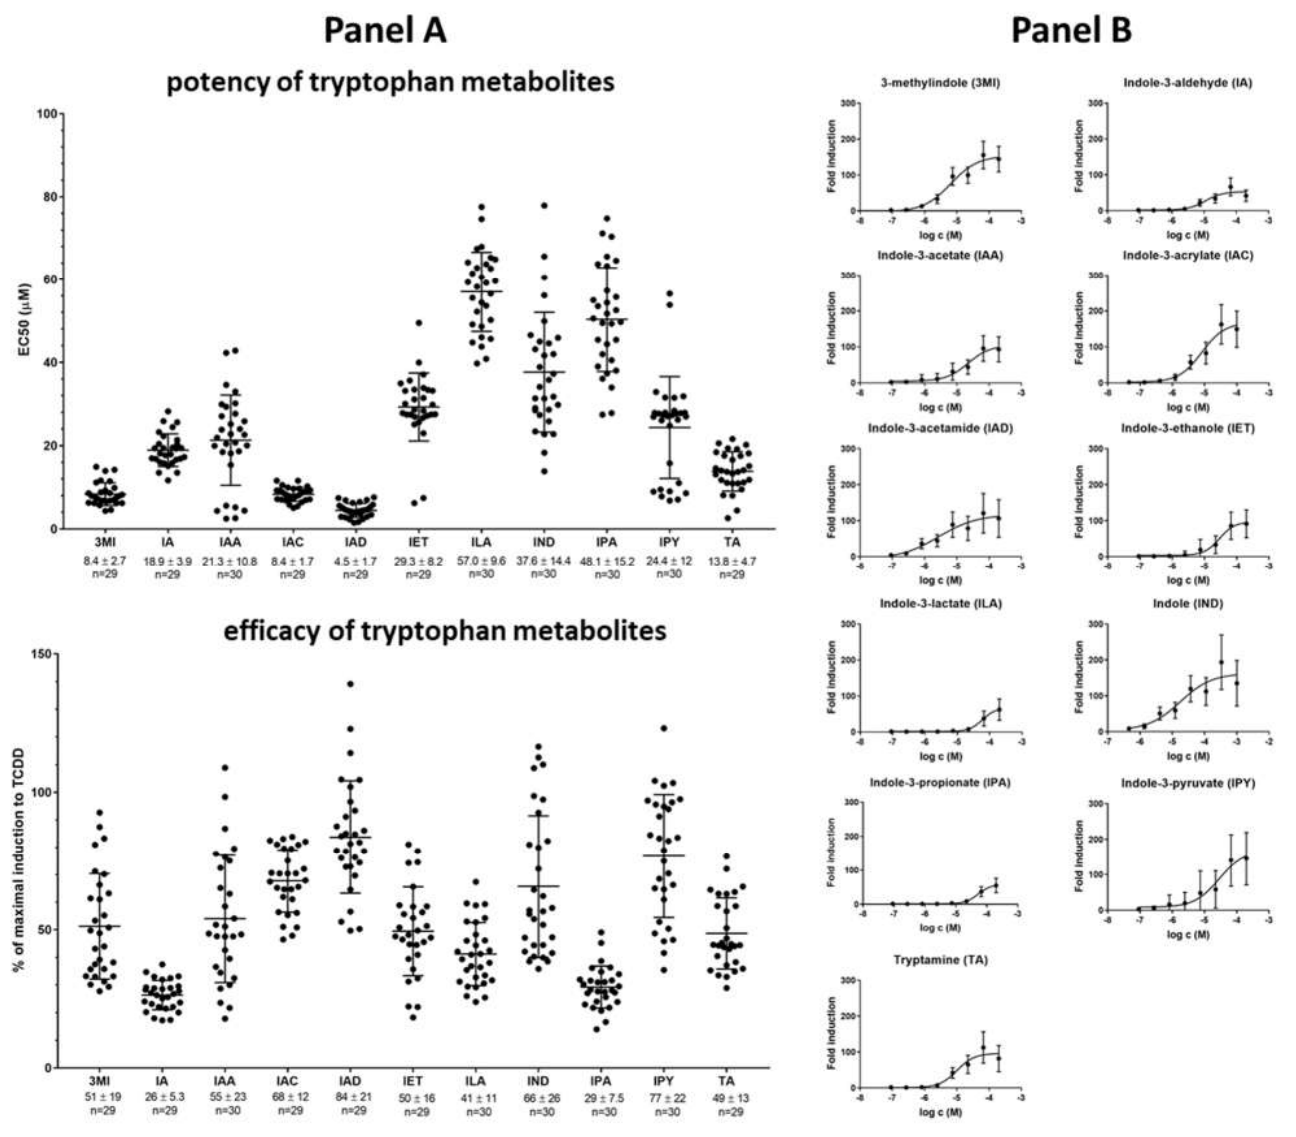
Figure 2. High-throughput screening of AHR transcriptional activity by tryptophan microbial catabolites (MICT). AZ-AHR cells were incubated for 4 h with vehicle (DMSO; 0.1% v / v ), TCDD (5 nM), or increasing concentrations of the tested compounds. Following the treatments, cells were lysed, and luciferase activity was measured. Panel ( A ): The column scatter plot represents the values of the half-maximal effective concentrations (potency; EC 50 ) and relative efficacies (a ratio of luciferase activity by MICT in highest concentration/luciferase activity by TCDD). Panel ( B ) : Dose–response assessment of AHR-dependent activity. Data are expressed as the fold induction of luciferase activity over control cells and are the mean ± SD from approximately 30 consecutive cell passages. The fold induction of TCDD was 200 ± 105 (n = 165). All values are statistically significant ( p < 0.01) in comparison to vehicle-treated